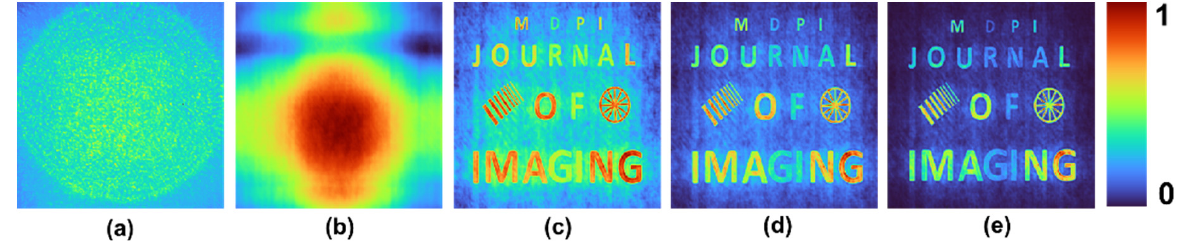
Figure 5. ( a ) Recorded PSF and ( b ) object intensity response. Reconstruction results using ( c ) NLR ( p = 1), ( d ) NLR ( p = 2) and ( e ) NLR ( p = 3) for LI-COACH with a QRL.